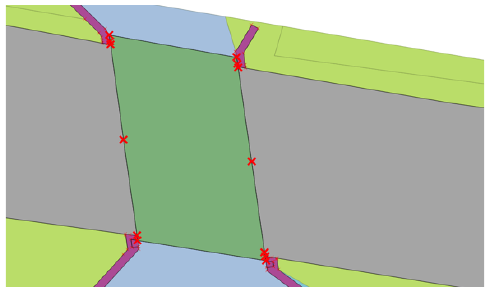
Figure 2: Bridge as modelled in BGT: The acquisition rules do not enforce topology between the green bridge at height level ‘1’ and the grey road parts at height level ‘0’ (as are all other objects in this example)